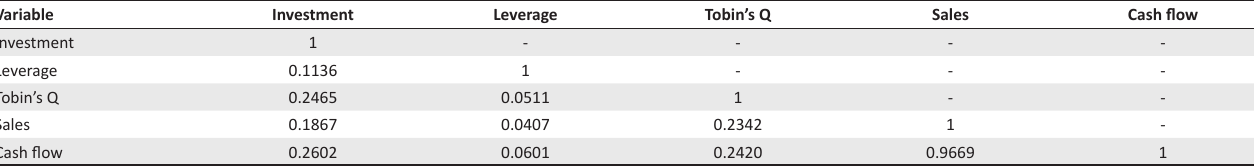
TABLE 2: Correlation matrix of the variables used in the regression when long-term debt is the dependent variable. Variable